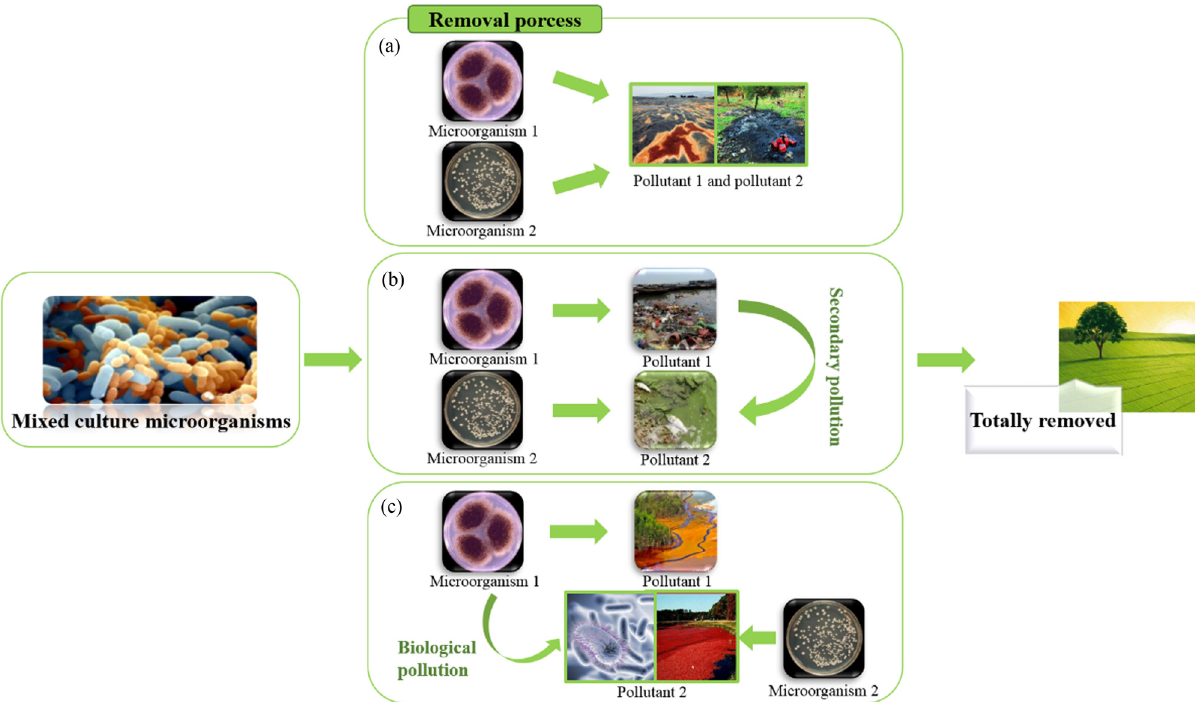
Figure 2: Three kinds of multiple contaminations and their removal process by mixed culture microorganisms. ( a ) Multiple pollutants; ( b ) secondary pollutants; and ( c ) microorganism self -